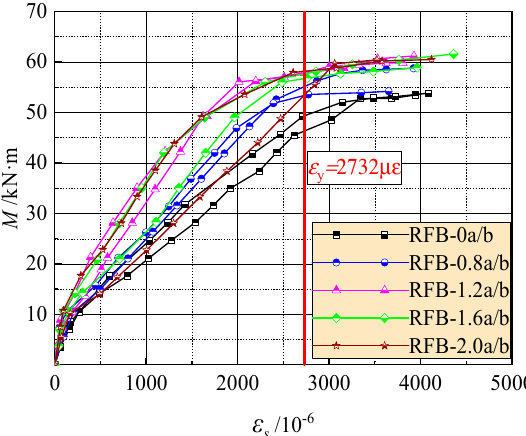
Figure 4. Changes of the strain of longitudinal tensile rebars with moment on the pure bending sections.